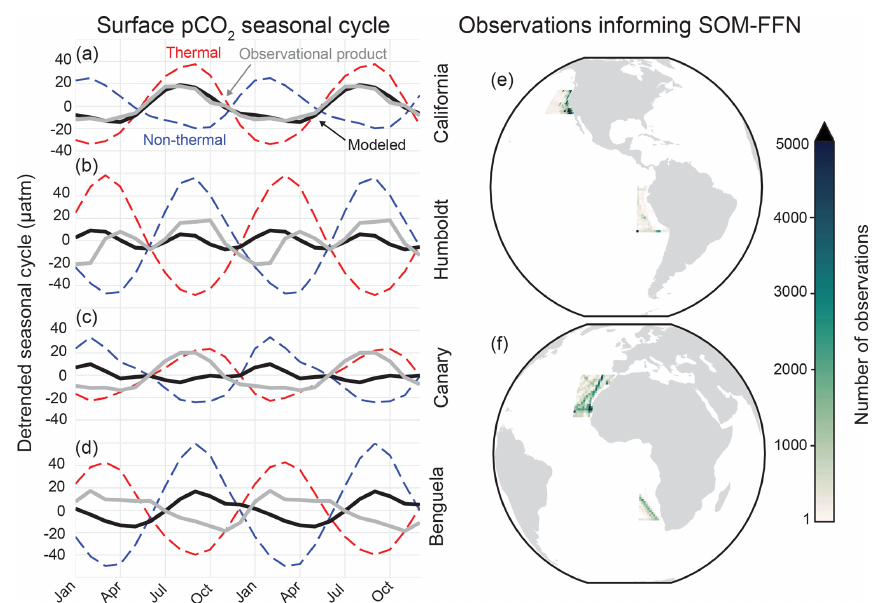
Figure 2. Detrended surface p CO 2 seasonal cycle from 1982–2015 for the SOM-FFN (gray) and the CESM-LENS ensemble mean (black) for the (a) CalCS, (b) HumCS, (c) CanCS, (d) and BenCS. Dashed red lines show the thermal component of the seasonal cycle for the CESM-LENS, and dashed blue lines show the non-thermal component. The total number of observations from SOCATv4 contributing to the SOM-FFN for the EBUSs is shown in (e) and (f)